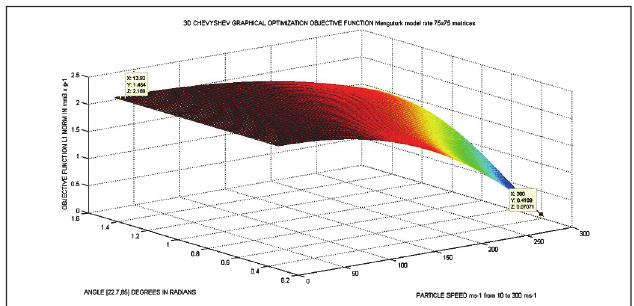
Fig 11. Chevyshev Graphical Optimization with Objective function at z axis. Exact Global minimum was reached at erosion optimal values of speed and impact angle. The searched erosion value is approximately 2.18 mm 3 /kg. Data cursor shows global minimum and global maximum.